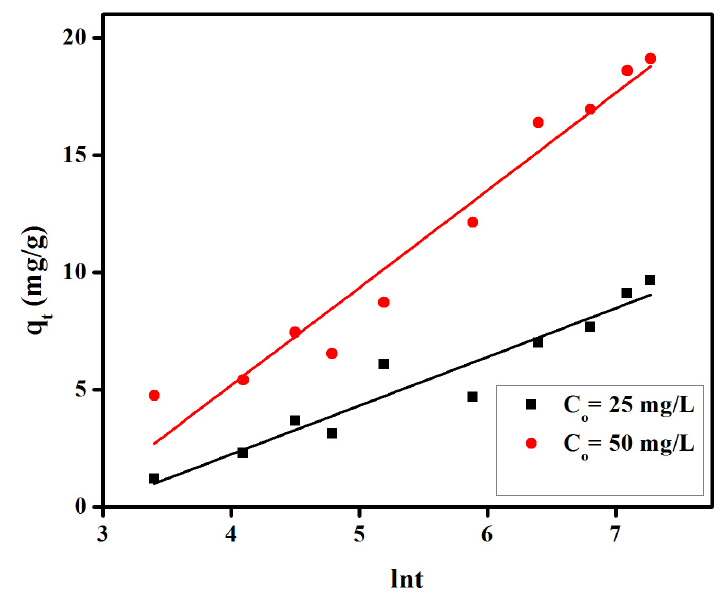
Figure 9. Elovich model for adsorption of congo red on anion exchange membrane EBTAC.